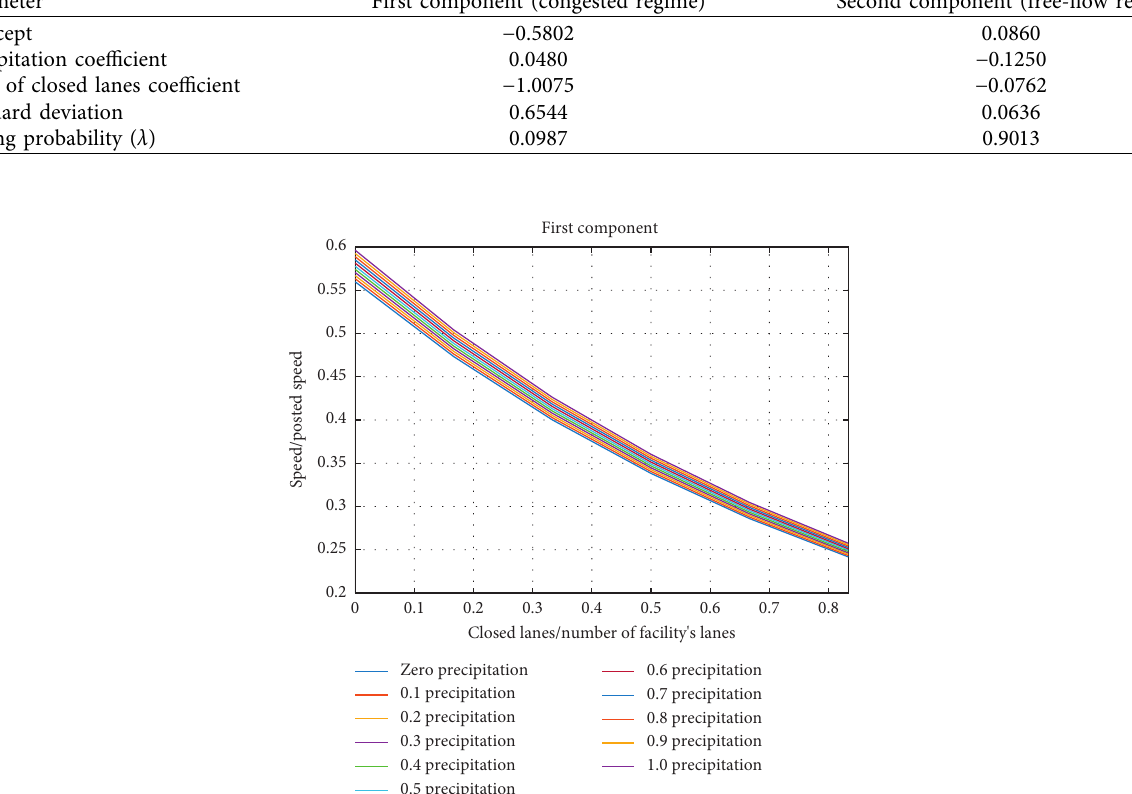
Figure 6: The change of the mean of the first component (congested regime) with the precipitation intensity and proportion of closed lanes.